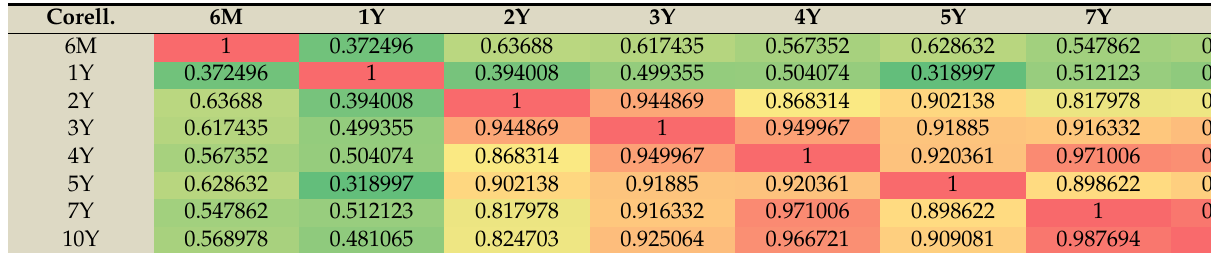
Table 3. Correlation matrix of Romanian weekly yield changes on 20 March 2020. Source: Bloomberg, own computation of the correlation matrix of yield